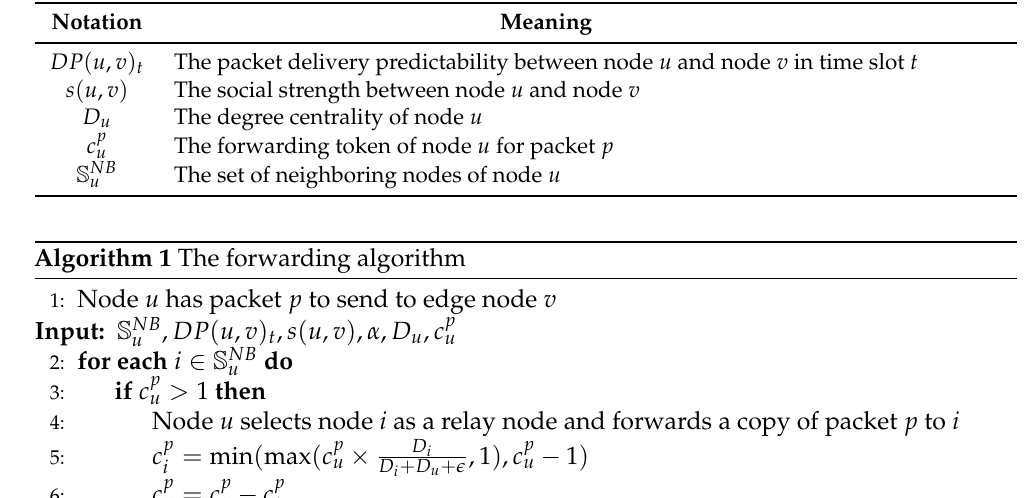
Table 2. Notations used in the proposed forwarding algorithm.